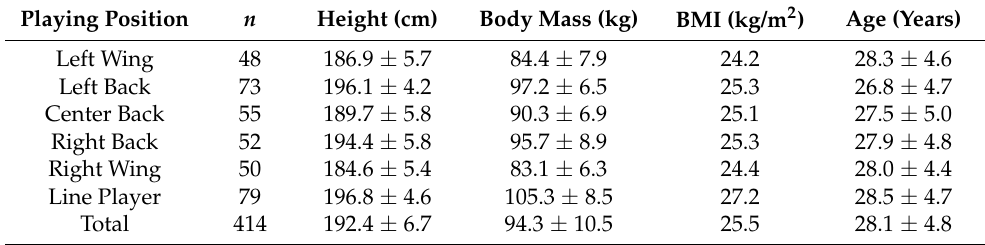
Table 1. Physical characteristics of the players (mean ± standard